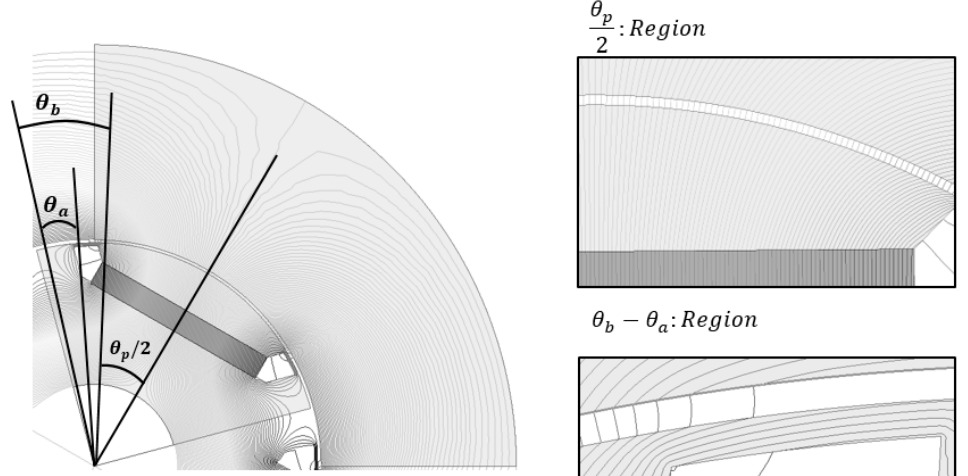
Figure 1. Three regions of the slotless flux line distribution by permanent magnet.